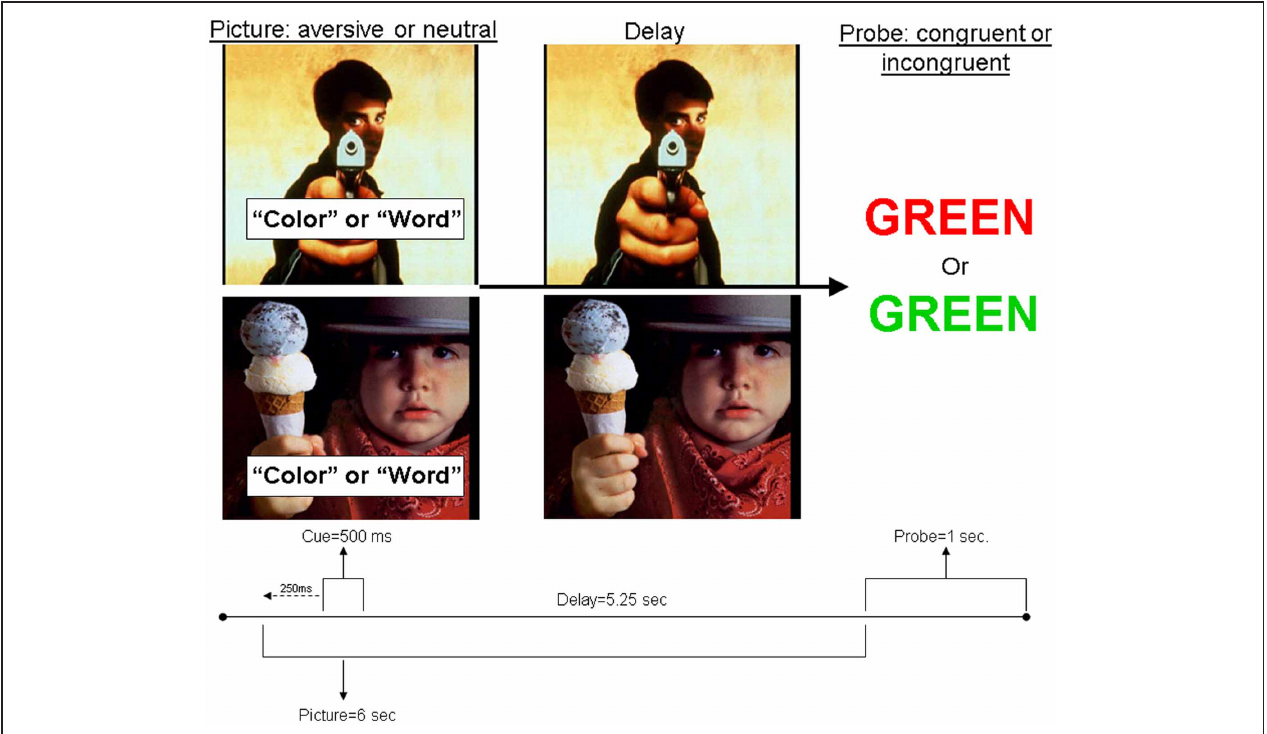
FIGURE 1 | Schematic of task